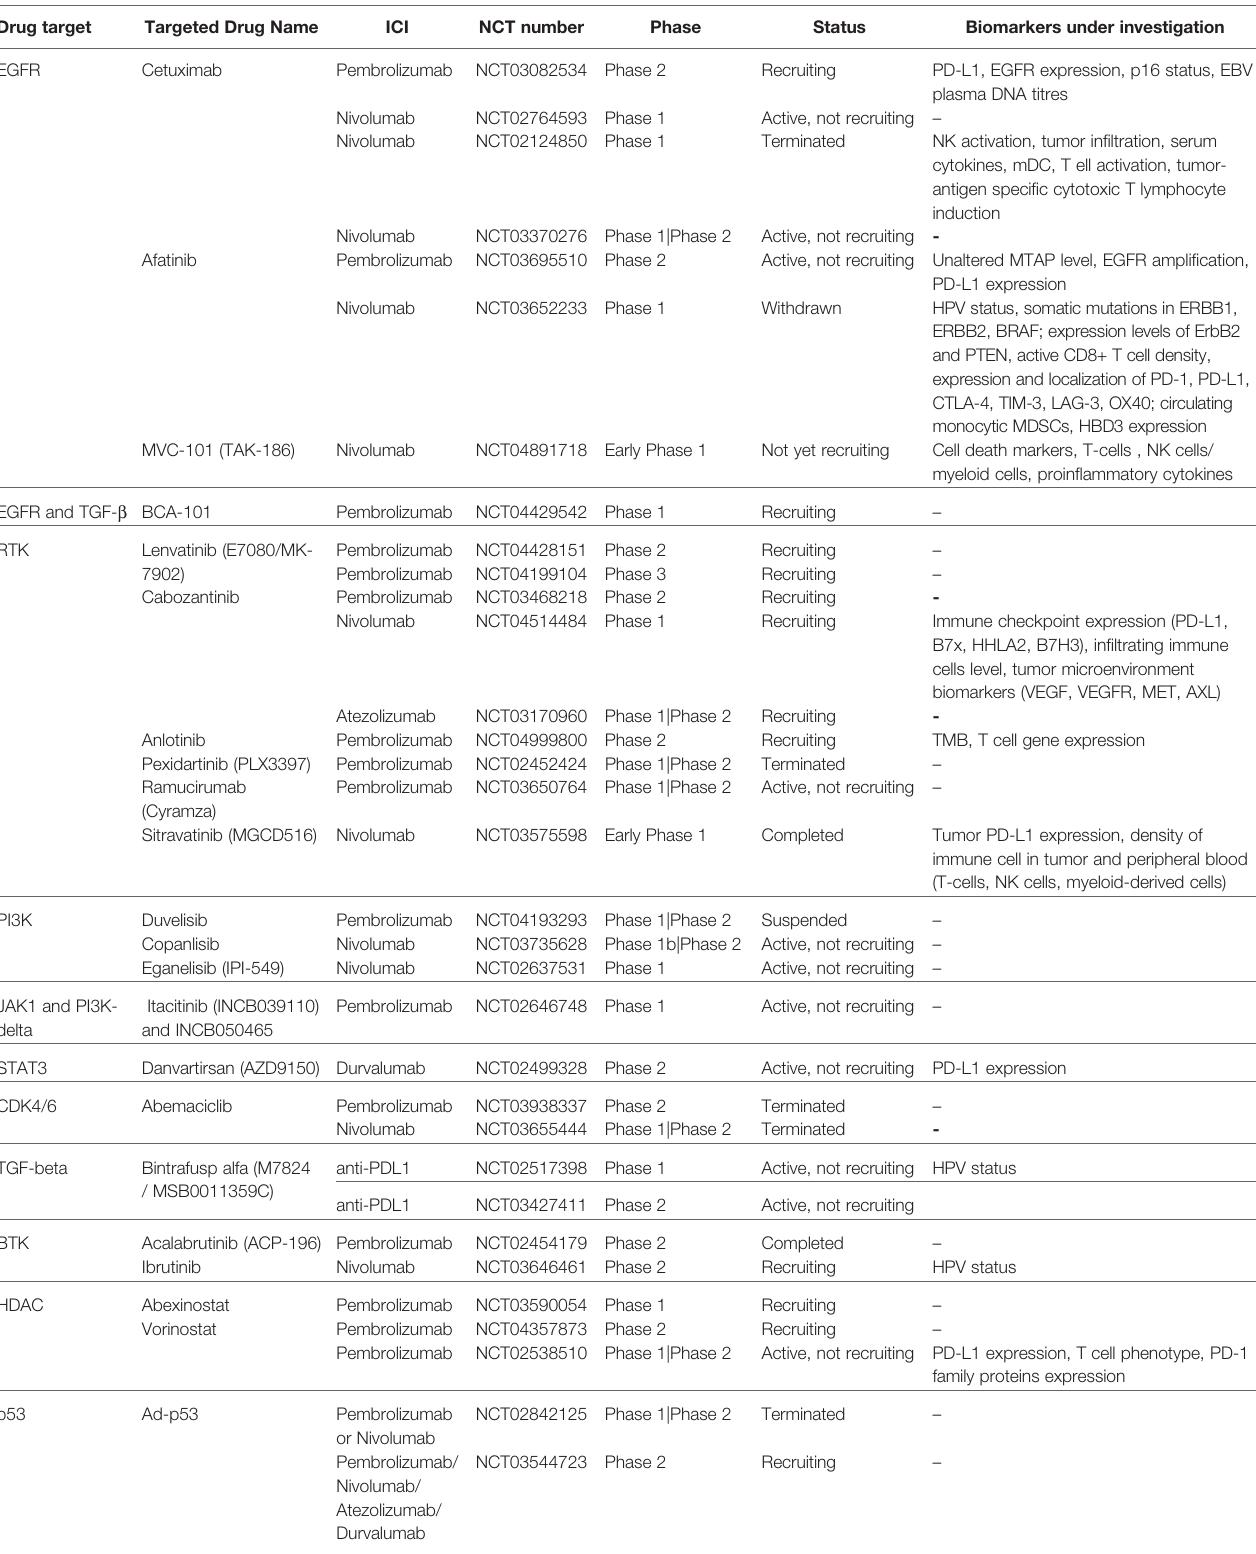
TABLE 1 | Overview of clinical trials involving the combination of targeted agents with ICIs for HNC